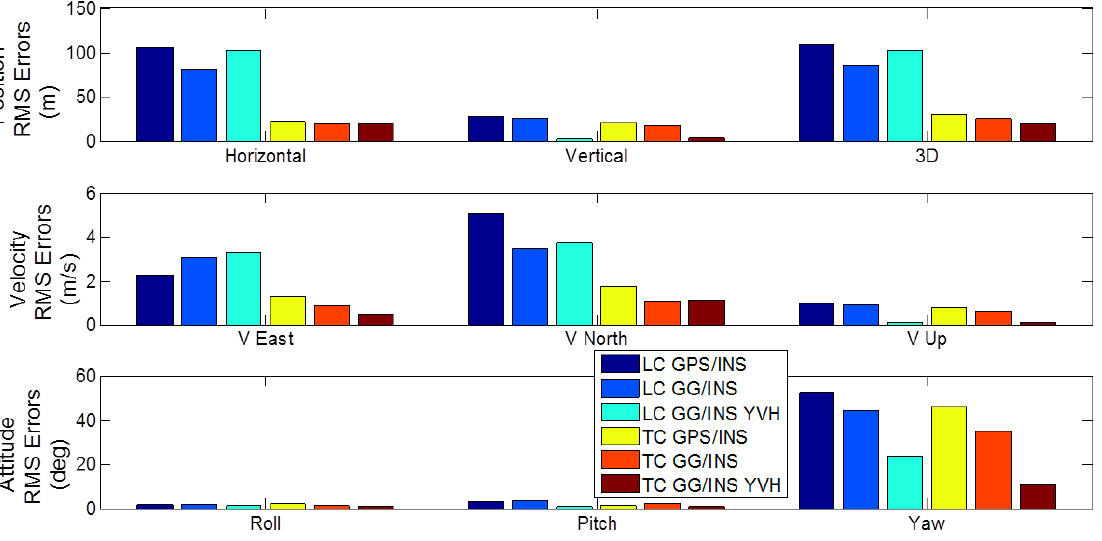
Figure 17. Comparison between LC and TC architectures in terms of position, velocity and attitude RMS errors (Segment